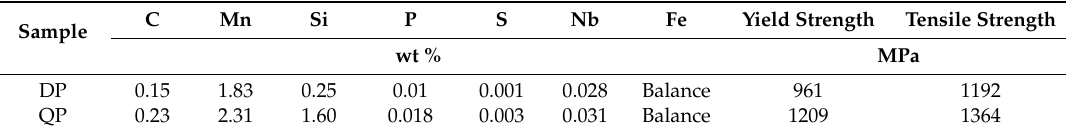
Figure 1. Diagrams describing the bending process and locations of electron backscattered diffraction (EBSD) and transmission electron microscopy (TEM) specimens. ( a ) Schematic diagram of the bending process; ( b ) Schematic diagram describing locations of EBSD and TEM specimens. The yellow rectangles represent the outer zone, center zone, and inner zone in the thickness direction; ( c ) Diagram of the bending samples. Table 1. Main chemical compositions and mechanical properties of materials used in experiments. DP: dual phase, QP: quenching and partitioning.